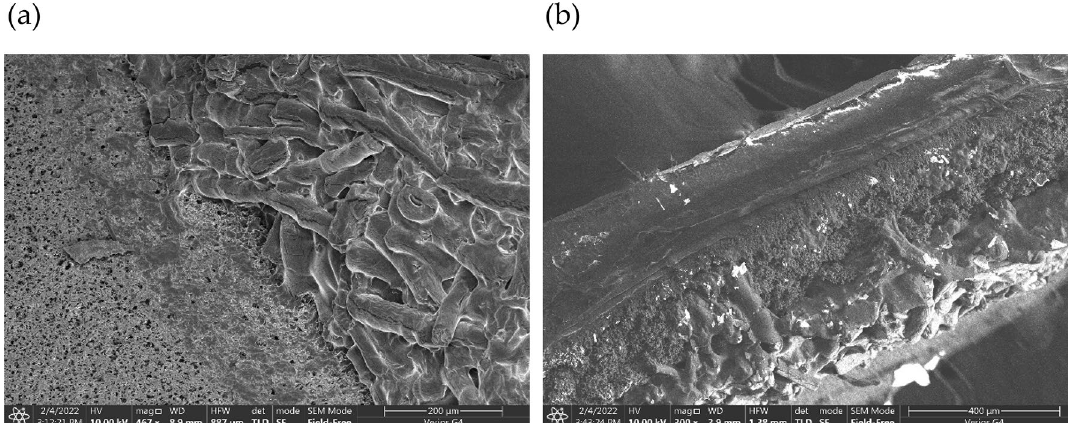
Figure 2. Scanning electron microscopy (SEM) analysis of cellulose fibers regenerated in situ over NC. ( a ) Top view at × 467 magnification and ( b ) cross section at × 300 magnification. The boundary region between NC and cellulose fibers is clearly visible in both